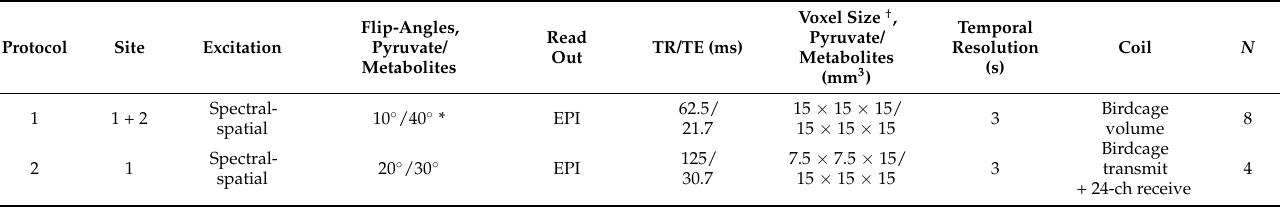
Table 1. Overview of the different protocols